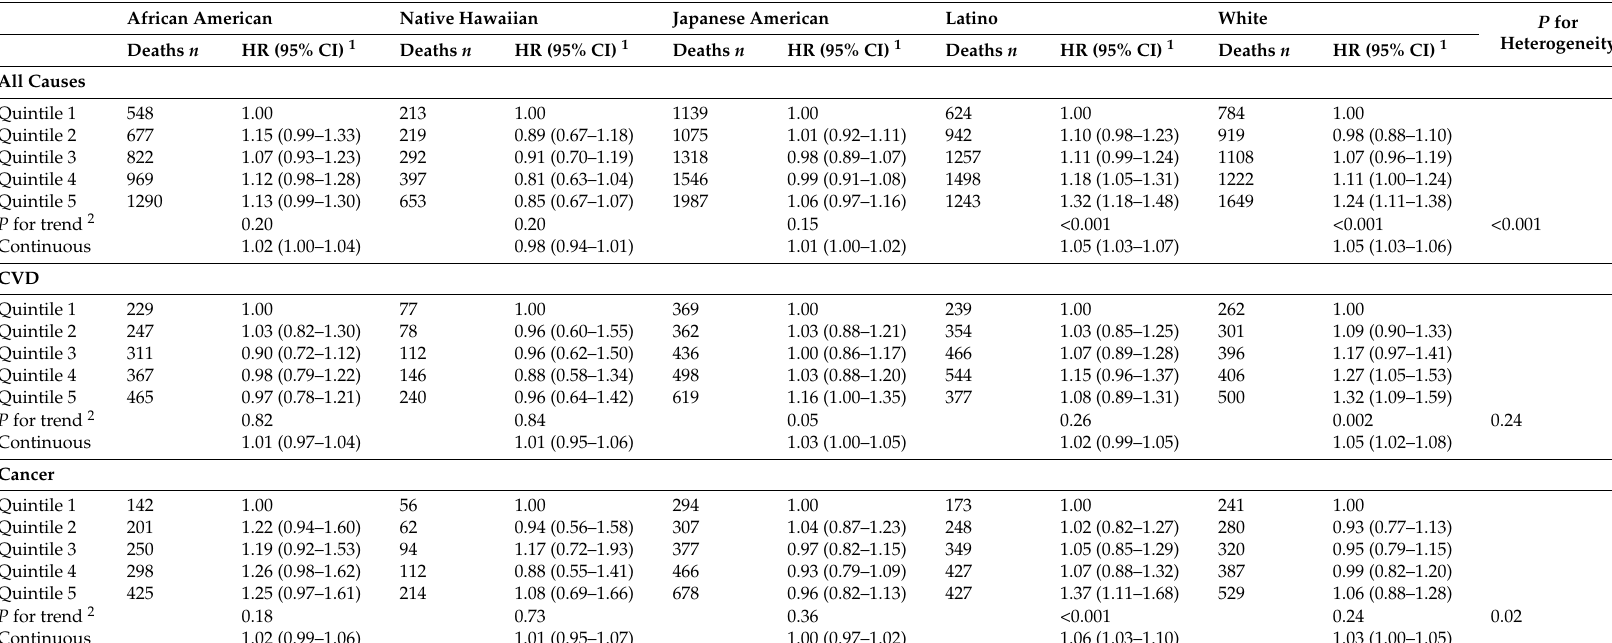
Table 3. Hazard ratios (HR) (95% confidence intervals (CI)) for all-causes, cardiovascular disease (CVD), and cancer mortality according to quintiles of Dietary Inflammatory Index scores by race/ethnicity among men in the Multiethnic Cohort,